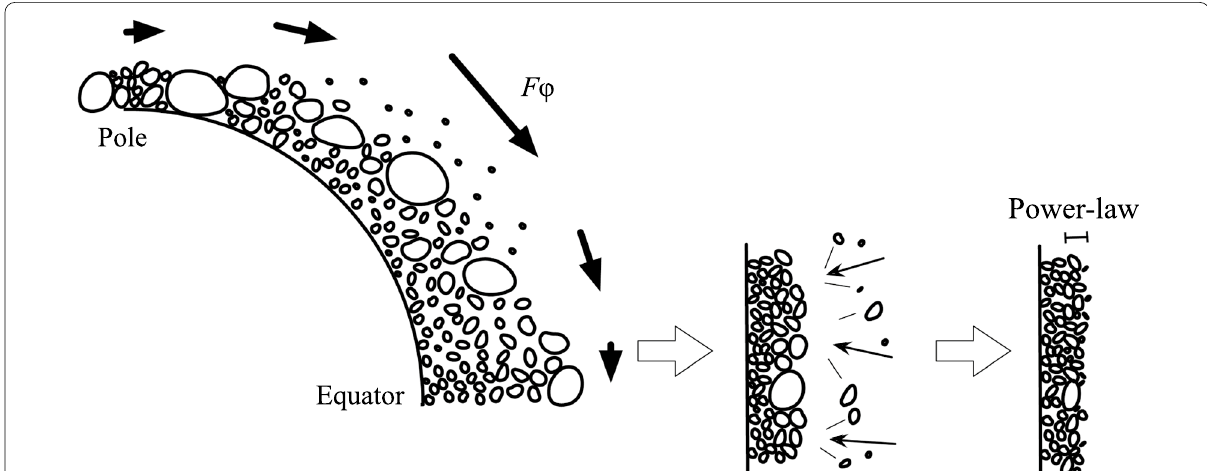
Fig. 6 Schematic illustration of Ryugu’s surface formation process. The flow along the surface is driven by F φ as an along-slope flow. As a result, segregation occurs and creates a vertically decreasing distribution of particles in size along the depth. Finer particles may acquire large random velocities to escape from the asteroid. The fragments with a power-law size distribution will then be produced by impacts. Thus, a 2-layered structure will be formed; an outermost surface layer consisting of the fragments with a power-law size distribution and a subsurface layer having a large number of particles with sizes within a specific